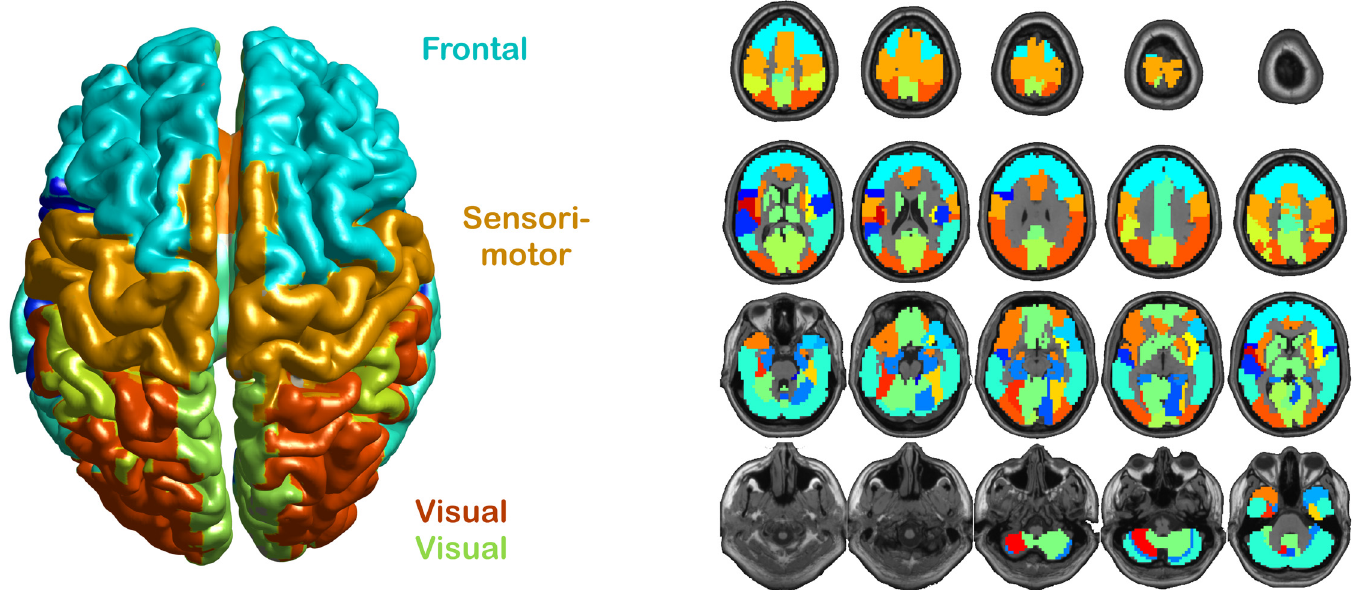
Fig 4. Area networks according to similarity analysis. (left) Topography of similar areas. (right) Slice view of the brain, including the cerebellum, with colour-coded similarity. A hierarchical clustering analysis (using negative log-likelihood between areas as distance measure) revealed several groups of areas that resemble previously identified brain networks. The frontal network (light blue) consists of bilateral medial and dorsolateral superior frontal gyrus, middle frontal gyrus, triangular inferior frontal gyrus, and right opercular inferior frontal gyrus. The sensorimotor network (orange) consists of bilateral pre- and postcentral gyri, paracentral lobule, and supplementary motor area. Two visual networks were found, a medial visual network (green) consisting of bilateral calcarine, cuneus, and precuneus and a parieto-occipital visual network (red) consisting of bilateral superior, middle, and inferior occipital gyri, superior parietal gyri, and supramarginal and angular gyri.